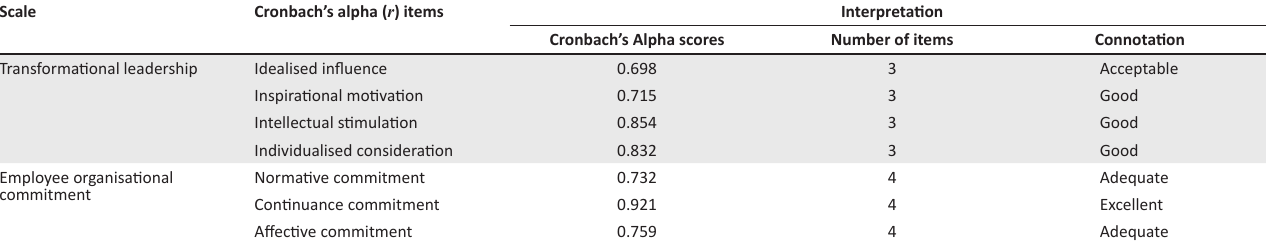
TABLE 2: Reliability of the perceived transformational leadership style and employee organisational commitment constructs. Scale